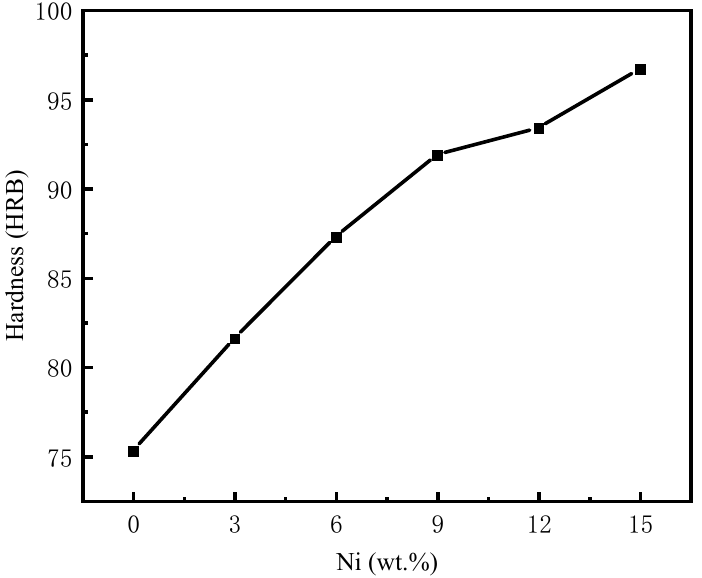
Figure 5. The hardness of the matrix of sintered samples with different Ni contents.